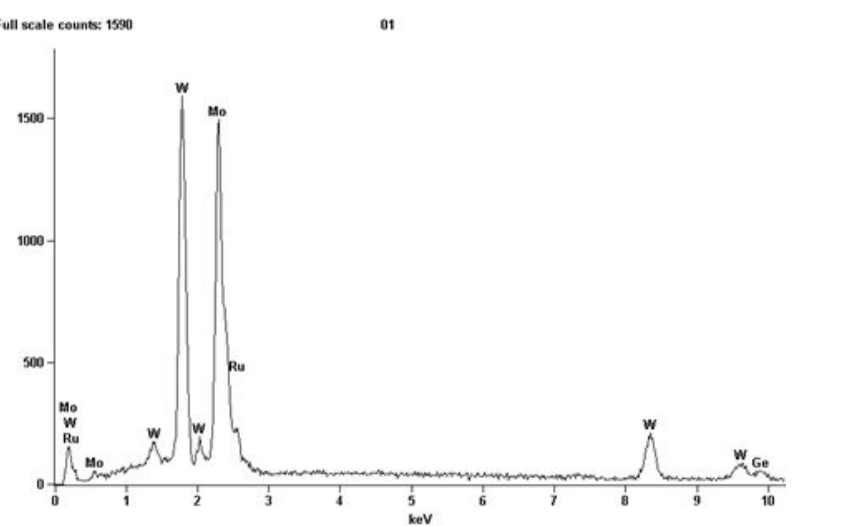
Figure 14. EDS full-scale counting spectrum taken in micrograph analysis in SEM micrograph with a 150x magnification in the junction